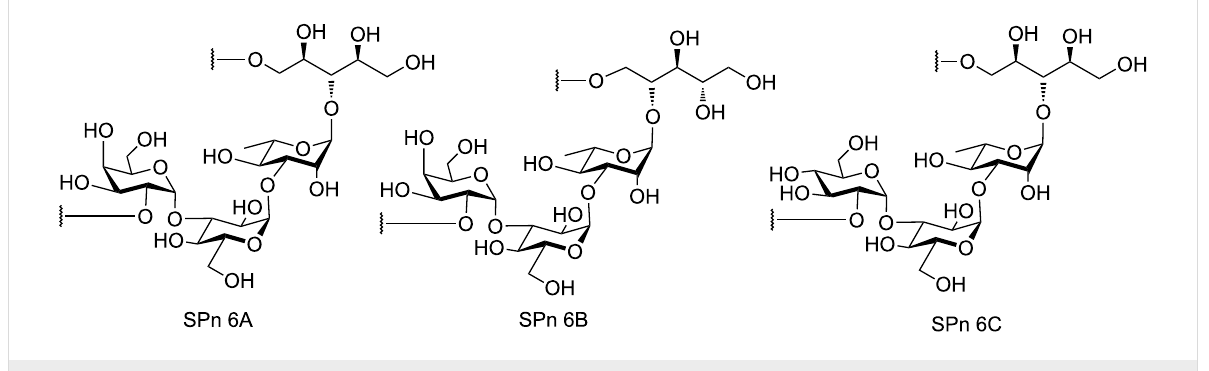
Figure 1: The tetrasaccharides associated with the pneumonicoccal serogroup 6.